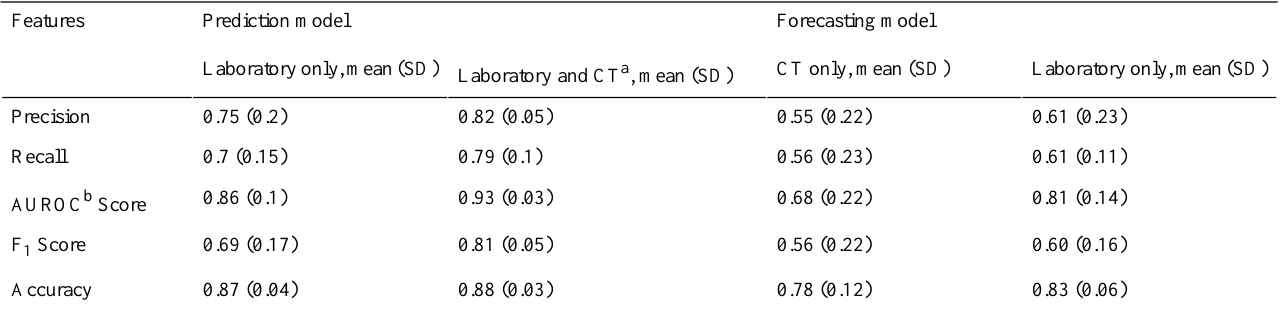
Table 2. Metrics of prediction and forecasting models. Mean and standard deviation values across 5 cross-validation splits are shown. AUROC: area under the receiver operating